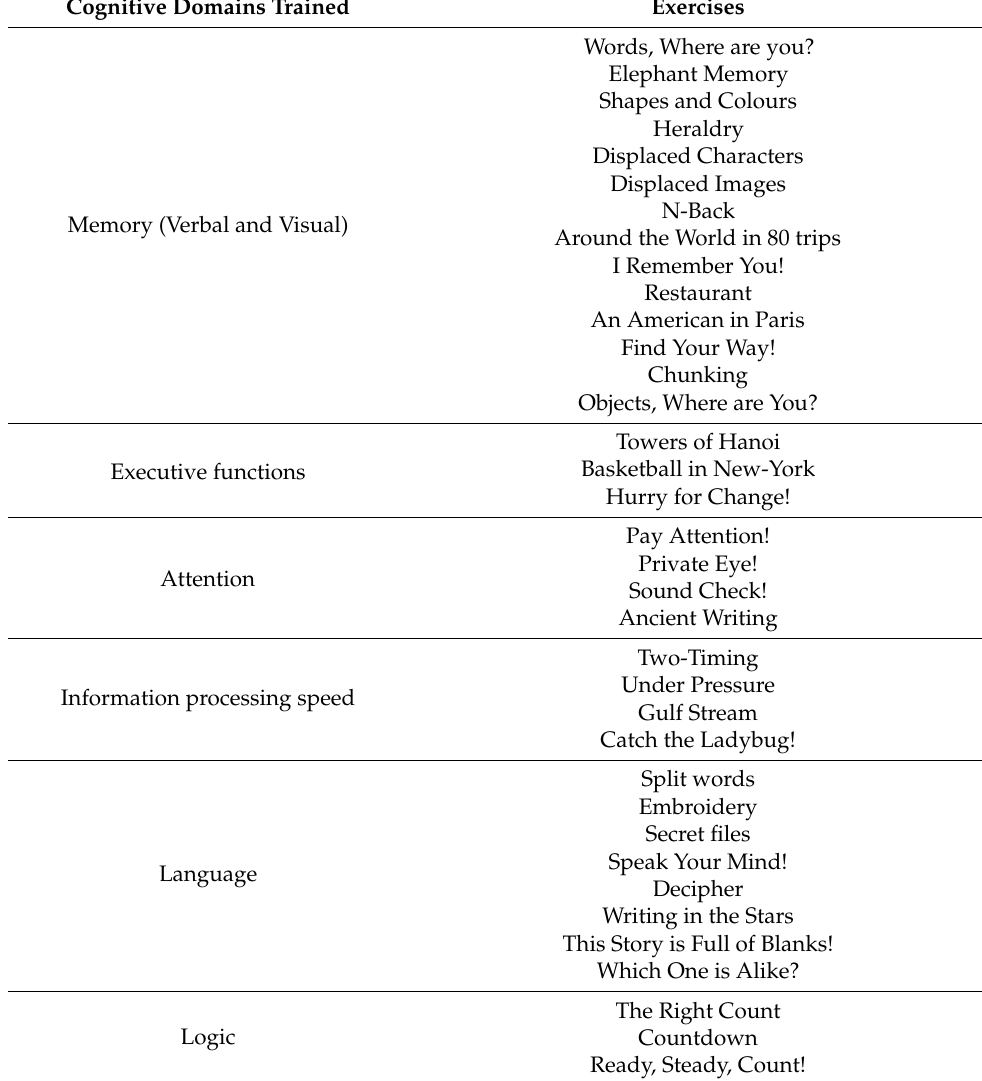
Table 2. HappyNeuron ® exercises used for cognitive